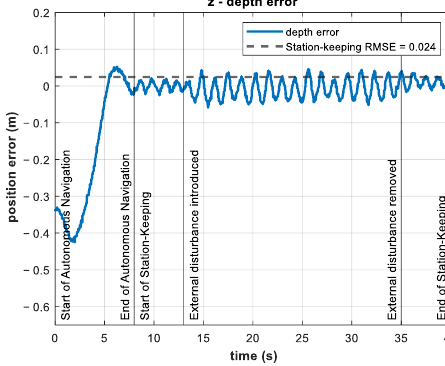
Figure 16. Experimental results for depth station-keeping with an external disturbance of ~20 N introduced in the interval 13 s ≤ 𝑡 ≤ 25 s . Depth ( left ) and tracking error ( right ).